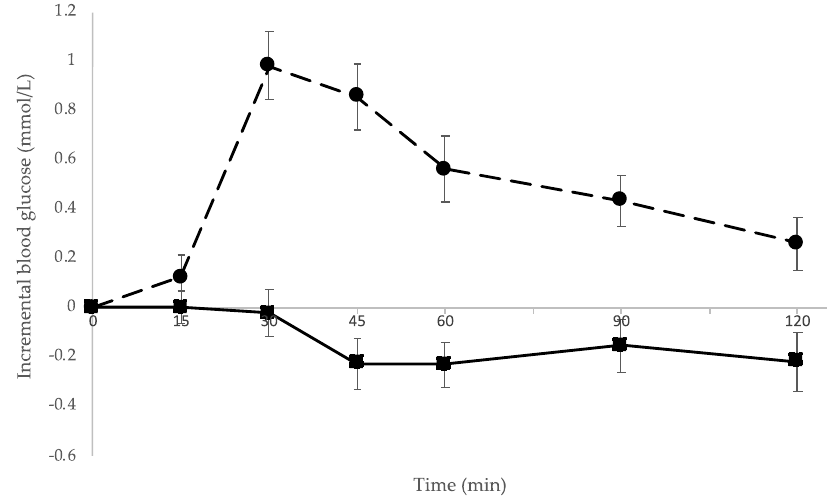
Figure 3. Mean (95% CI) incremental blood glucose response after consuming almonds and biscuits. iAUC was compared using a linear mixed model with random effects included for participants to accommodate the crossover design. iAUC (calculated using the trapezoidal rule [43], where negative values were treated as zero) for the almonds was statistically and practically significantly lower compared to the biscuits ( p < 0.001). Solid line with (cid:4) , almonds; dashed line with • ,